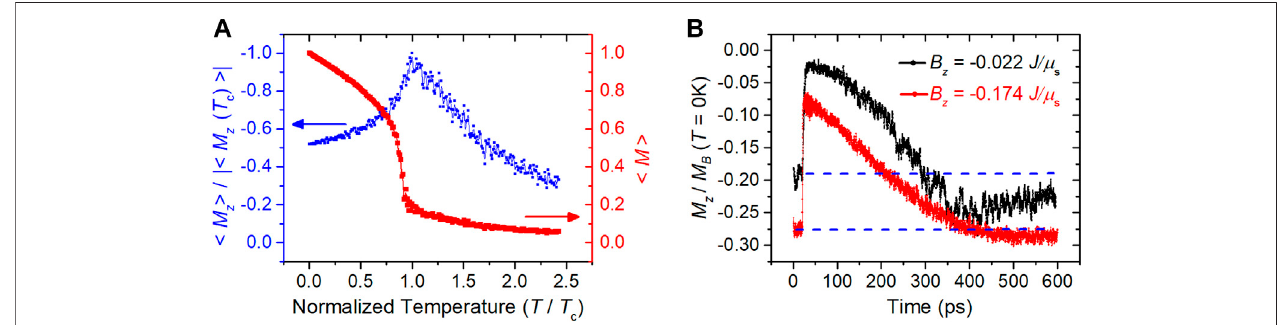
FIGURE 4 | (A) Simulated thermal-averaged out-of-plane magnetization component < M z > and magnetization < M > of equilibrium states as functions of temperature T , under B z (cid:1) − 0 . 174 J / μ s ( μ s isthe atomistic magnetic moment).Here < M z > is normalized in theunit of | < M z (cid:5) T c (cid:6) > | , with < M z (cid:5) T c (cid:6) > representing the out-of-plane magnetization at Curie temperature T c . (B) Simulated laser-induced dynamics of out-of-plane magnetization component M z under different effective magnetic fi eld B z . Here M z is scaled in the reduced unit of M B (cid:5) T (cid:1) 0K (cid:6) , which denotes the magnetization under magnetic fi eld B z and temperature T (cid:1) 0K. The initial values of M z before excitation are marked by the blue dashed